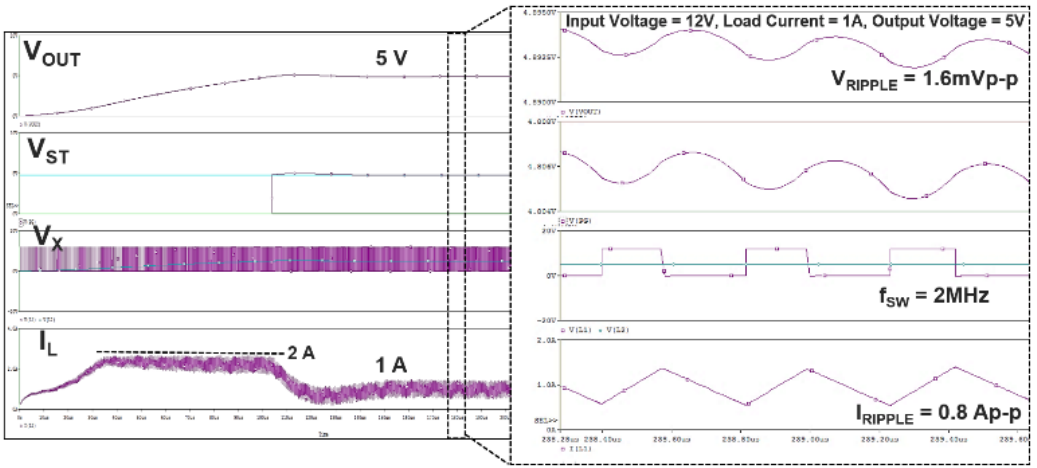
Figure 13. Simulation results of the buck-boost DC-DC converter. Reprint with permission